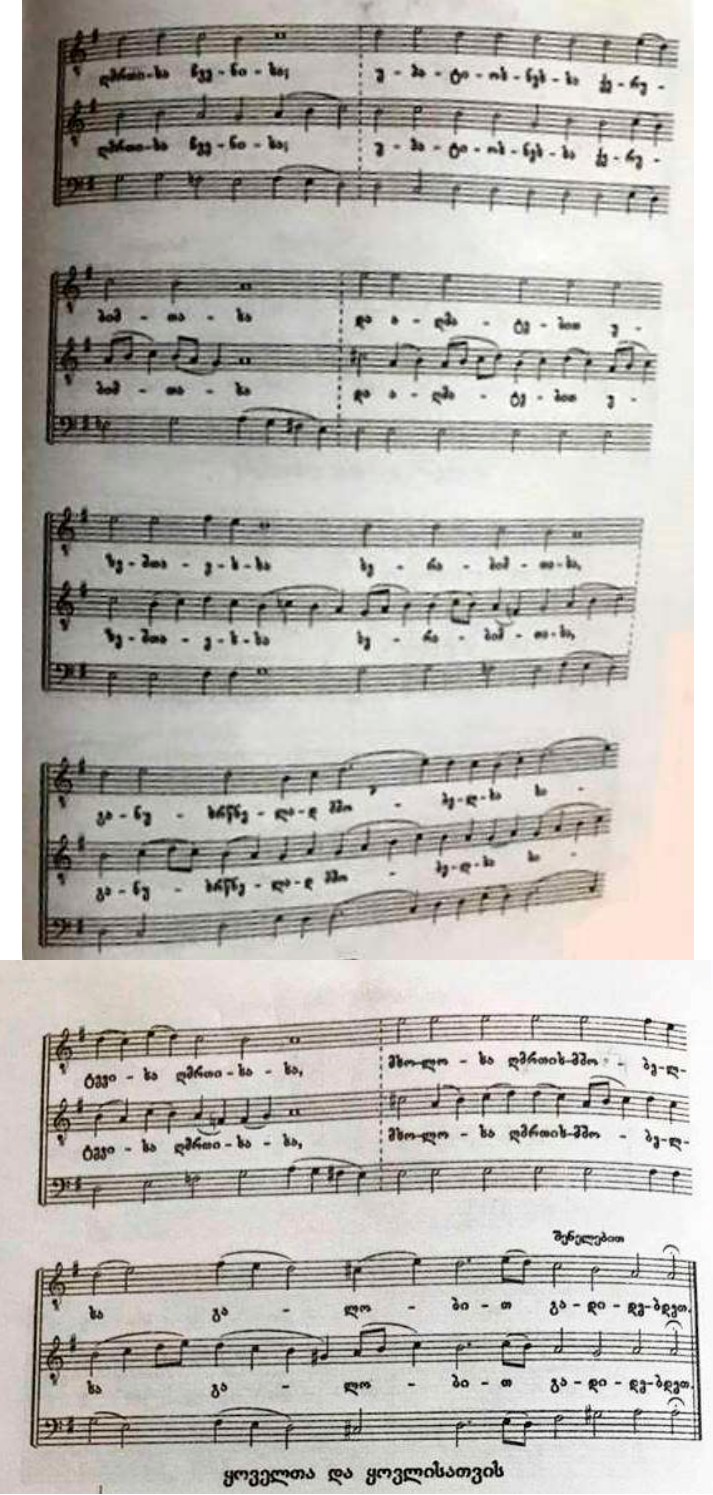
Figure 16. It Is Truly Meet; Svetitskhoveli School.